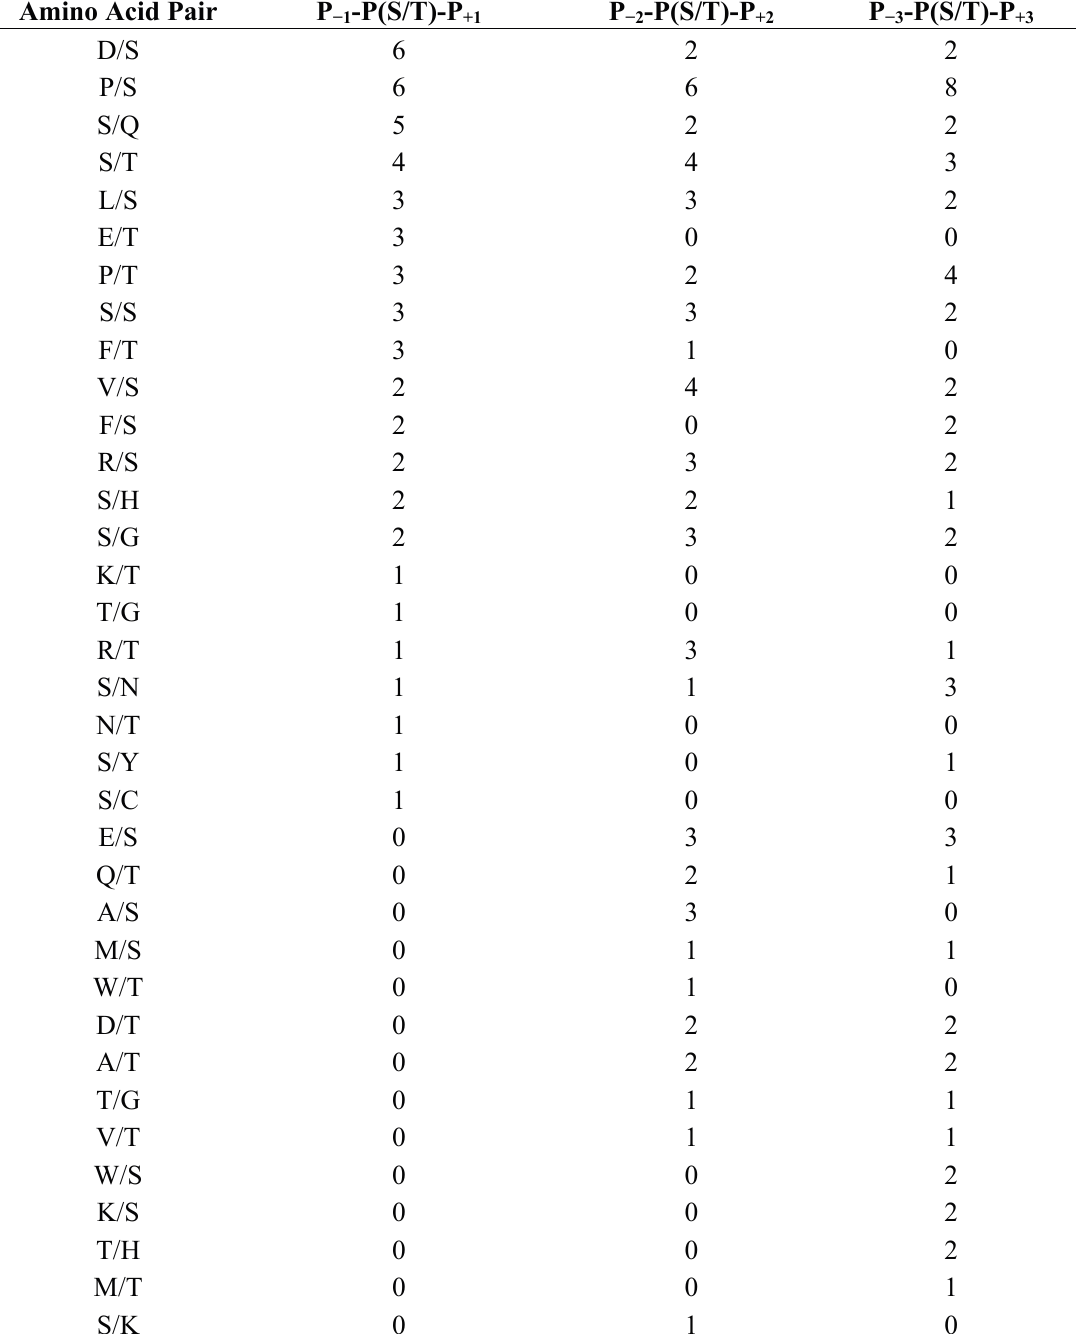
Table 2. Count of amino acid pairs in p53 phosphorylation